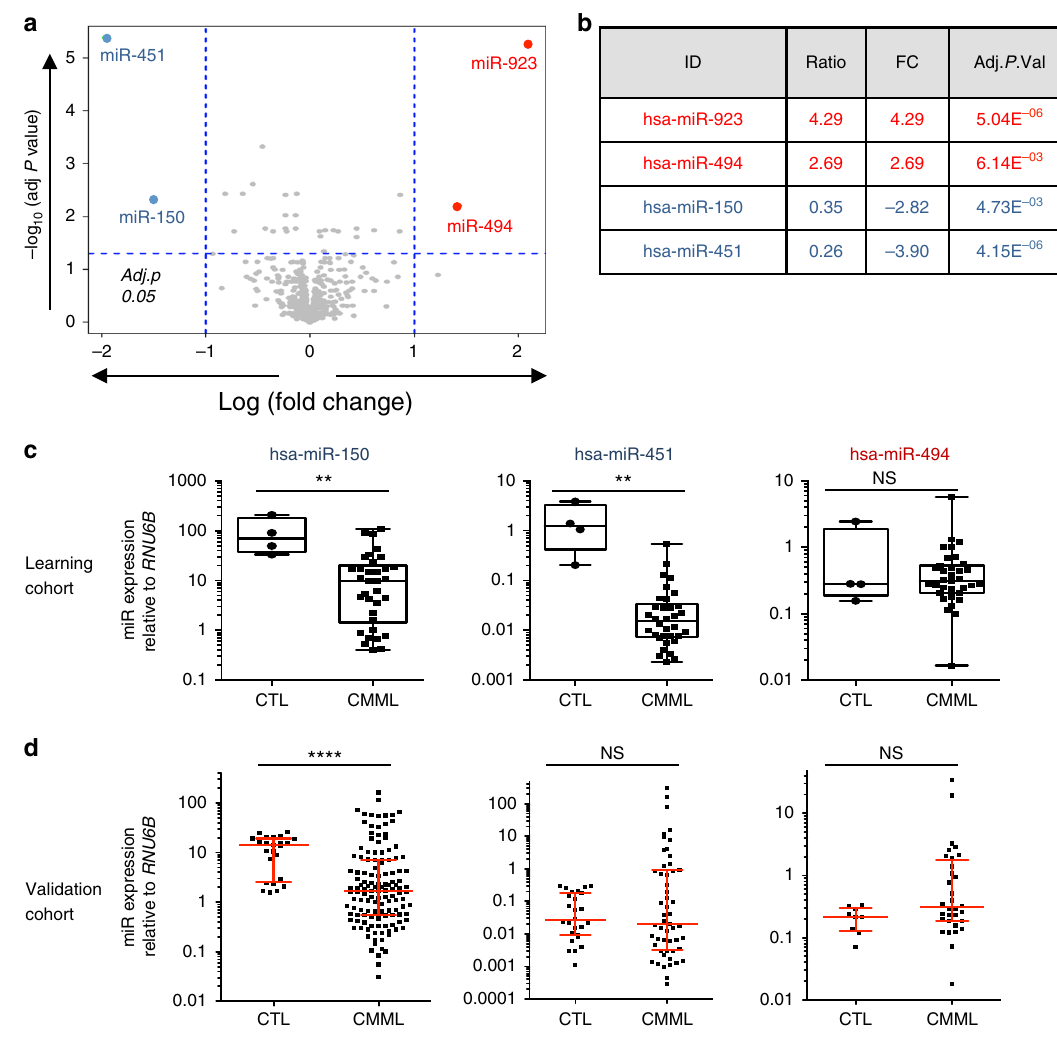
Fig. 1 Differentially expressed miRNA from control and CMML patient-sorted CD14 + . a Volcano plot showing the differentially expressed miRNAs in CD14 + cell-sorted monocytes from CMML ( n = 33) and healthy donor ( n = 5 + pool of fi ve samples) peripheral blood samples (learning cohort), as measured using v12.0 Agilent microarray. X -axis, log 2 fold-change value; Y -axis, − log 10 (adjusted P value). b List of the four miRNAs identi fi ed as deregulated in the learning cohort. Of note, hsa-miR-923 up-regulation is a known artifact of the v12.0 version of these microarrays. c Box plot showing the relative expression of hsa-miR-150, hsa-miR-451, and hsa-miR-494 analyzed by qRT-PCR in samples of the learning cohort (center line: median; whiskers: min to max). d qRT- PCR analysis of the relative expression levels of hsa-miR-150 (CTL = 24; CMML = 133), hsa-miR-451 (CTL = 24, CMML = 53) and hsa-miR-494 (CTL = 9; CMML = 32) in an independent validation cohort. Red lines, median with interquartile range; Mann – Whitney test: ** P < 0.01; **** P < 0.0001.